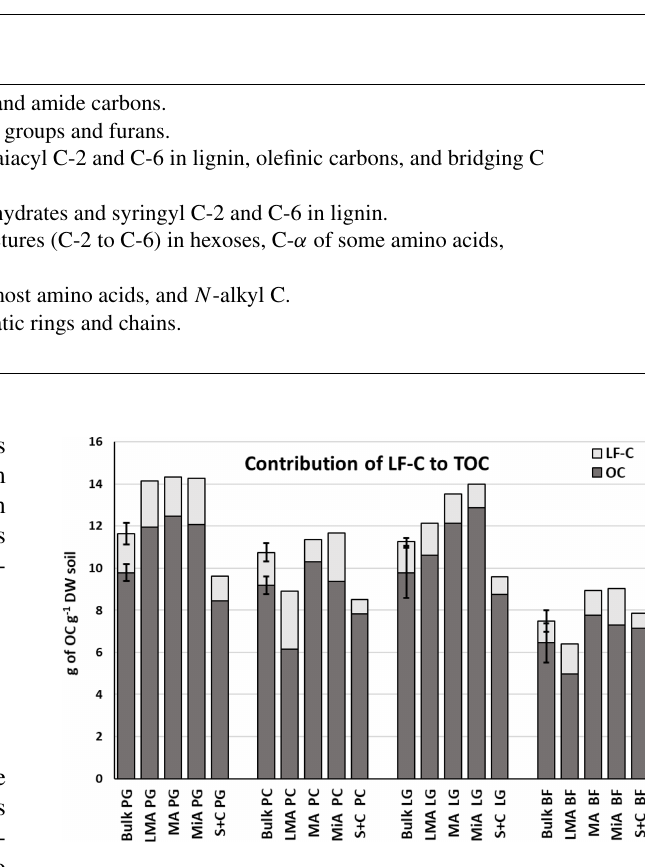
Figure 2. Light fraction carbon (LF-C) contribution to total organic carbon (TOC) in bulk soil ( n = 3) and density fractions ( n = 1) for different treatments (PG – permanent grassland; PC – permanent cropping; LG – ley grassland; and BF – bare fallow soil). No signif- icant differences between treatments ( P < 0 . 05) for bulk samples were found. Error bars show the calculated standard deviations for replicate